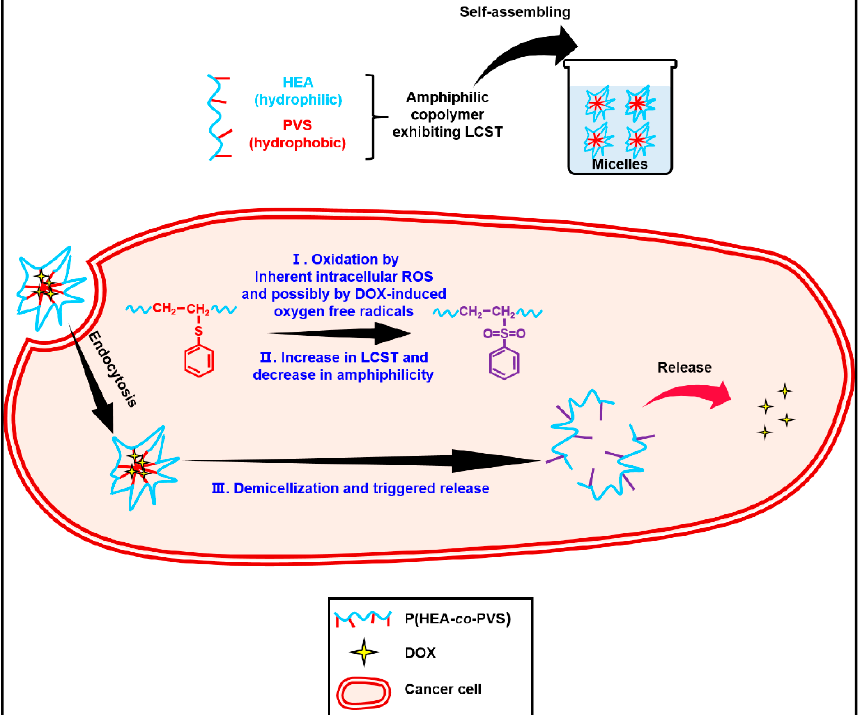
Figure 1. Schematic of oxidation- and temperature-responsive poly(hydroxyethyl acrylate- co -phenyl vinyl sulfide) P(HEA- co -PVS) micelle being used as a potential drug carrier for doxorubicin (DOX). Amphiphilic P(HEA- co -PVS) can be self-assembled into micelles in an aqueous solution. If the micelles are exposed to an oxidative environment, the PVS unit can be oxidized, the copolymer can undergo an increase in its lower critical solution temperature (LCST) and lose its amphiphilic property, and the micelles will be disassembled, resulting in an oxidation- and temperature-triggered release. Once the micelles are internalized into cancer cells, they can release their payload in response to the oxidative intracellular condition (inherent intracellular reactive oxygen species (ROS) plus DOX-induced oxygen free radicals), leading to enhanced anticancer e ffi